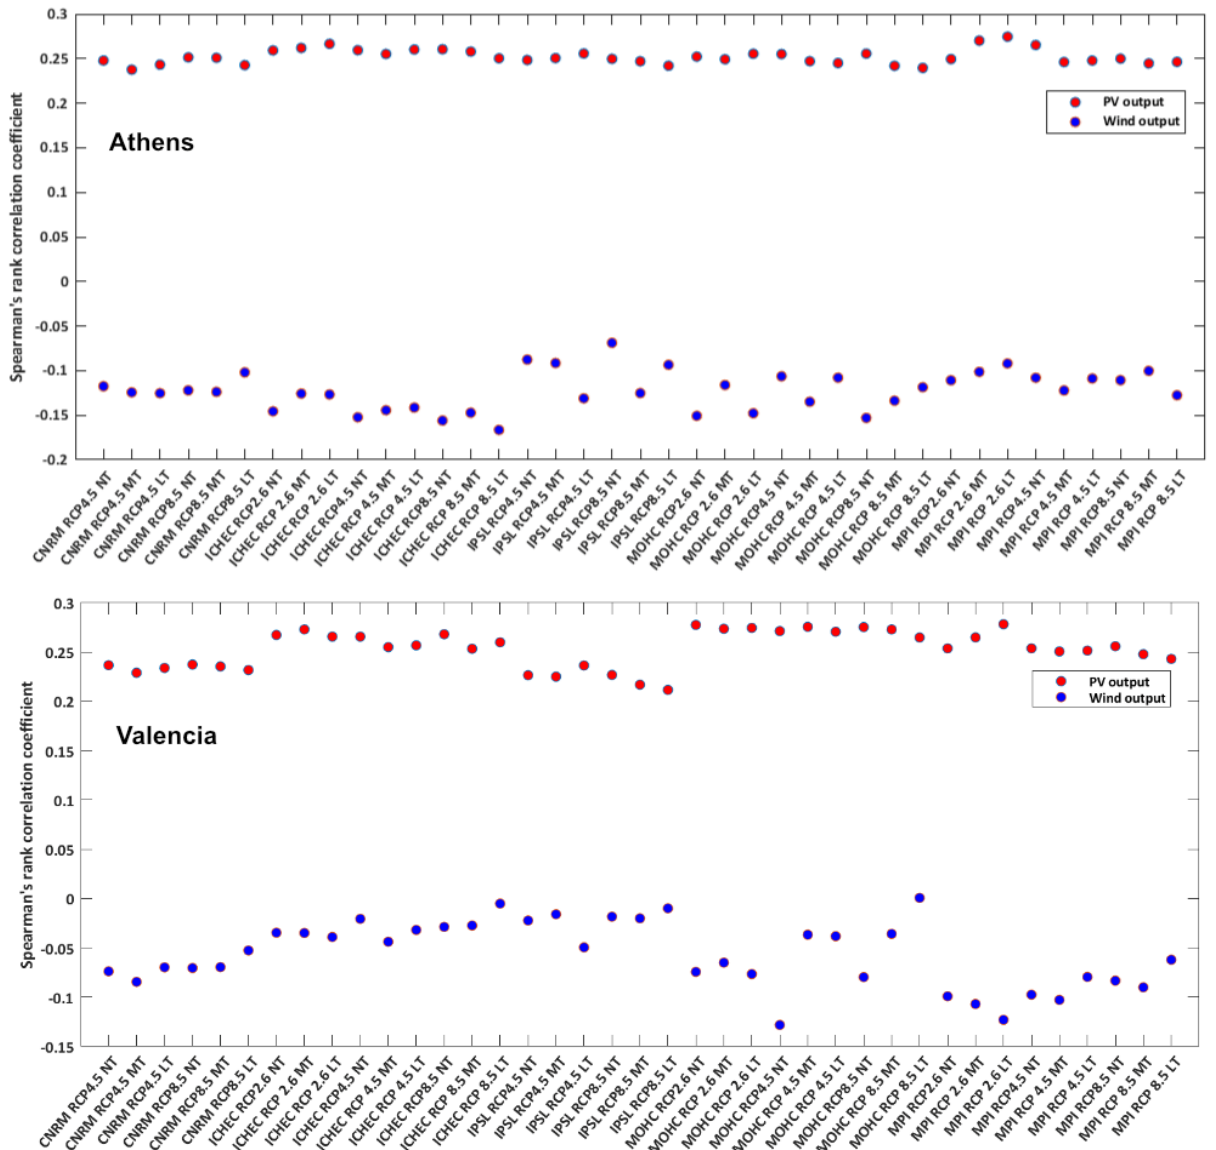
Figure 8. Spearman’s correlation between temperature and solar or wind output (Athens and Va- lencia).